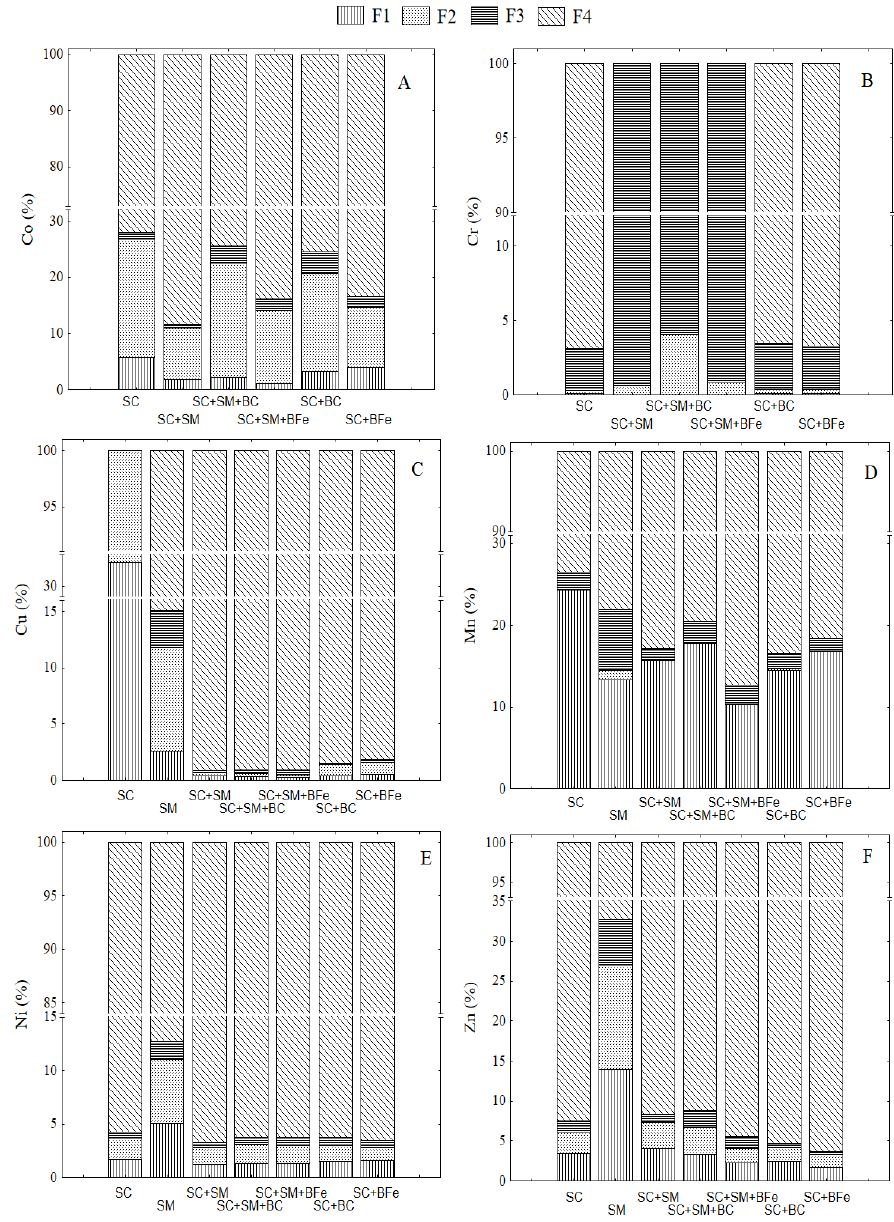
Figure 2. Fractionation of Co ( A ), Ni ( B ), Cu ( C ), Cr ( D ), Mn ( E ), and Zn ( F ) in the soil after the experiment. Exchangeable fraction (F1), linked to exchangeable cations and carbonates, reducible fraction (F2), linked to oxides and hydroxides of Fe and Mn; oxidizable fraction (F3), complexed by organic matter and sulfides; and residual fraction (F4), associated with silicate minerals. SC = contaminated soil, SM = forest soil, SC + SM = contaminated soil + forest soil, SC + SM + BC = contaminated soil + forest soil + biochar, SC + SM + BFe = contaminated soil + forest soil + biochar Fe impregnated, SC + BC = contaminated soil + biochar, SC + BFe = contaminated soil + biochar Fe